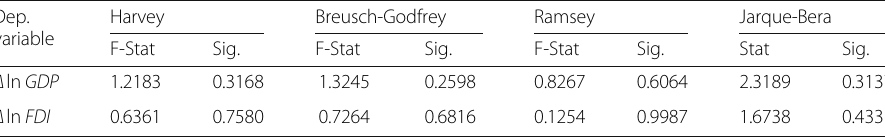
Table 6 Results from different diagnostic tests Dep.